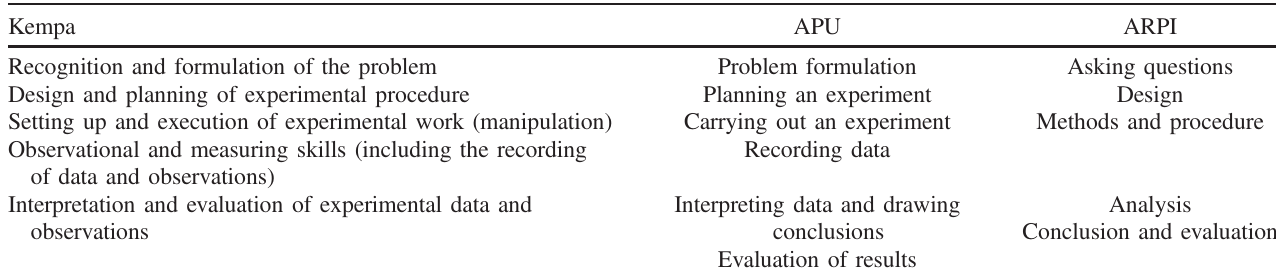
TABLE III. The phases of ARPI overlap with the phases as distinguished in the APU model and by Kempa.